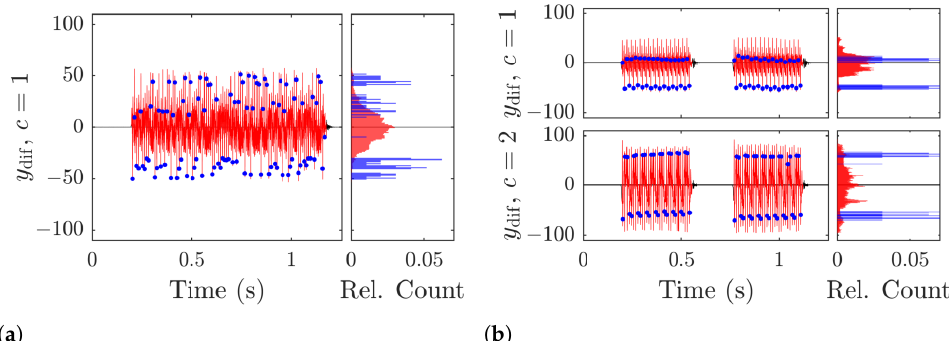
Figure 10. Time domain plot of the detected frames (red) and estimated symbols (blue dots). ( a ) Single band communication; ( b ) Dual-band communication. The symbol difference is not optimally detected, as the amplitude of the signal exceeds the amplitude of the estimated symbols. The histograms to the right of each time plot are normalized by the total number of samples (red) and symbols (blue) in each